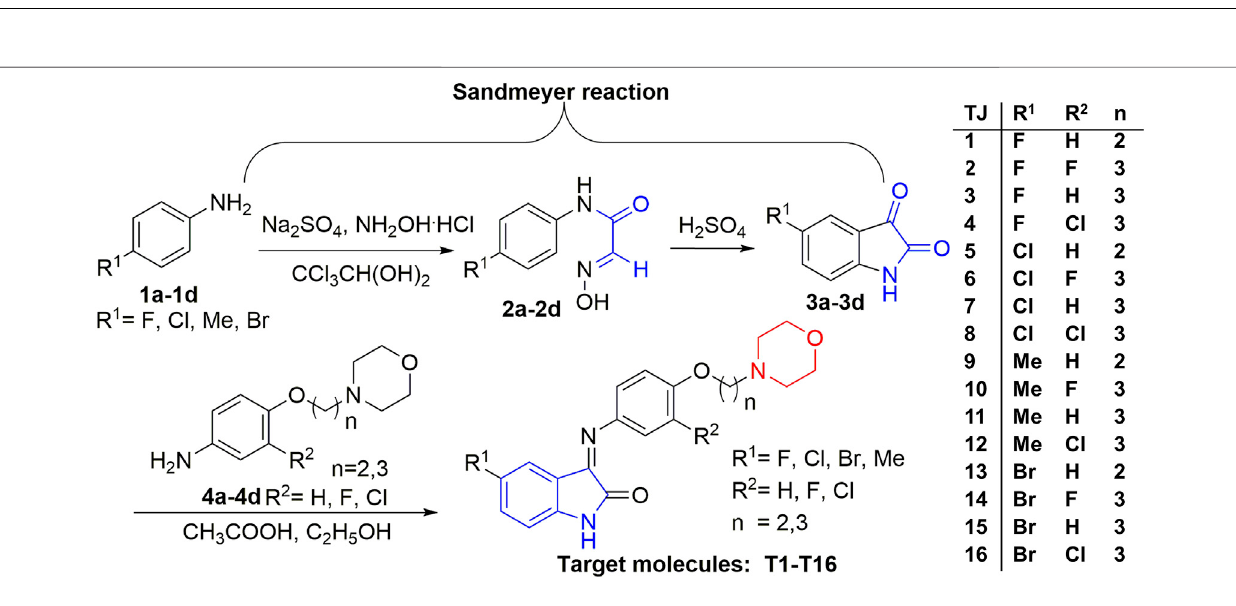
FIGURE 5 | Synthesis route of the target